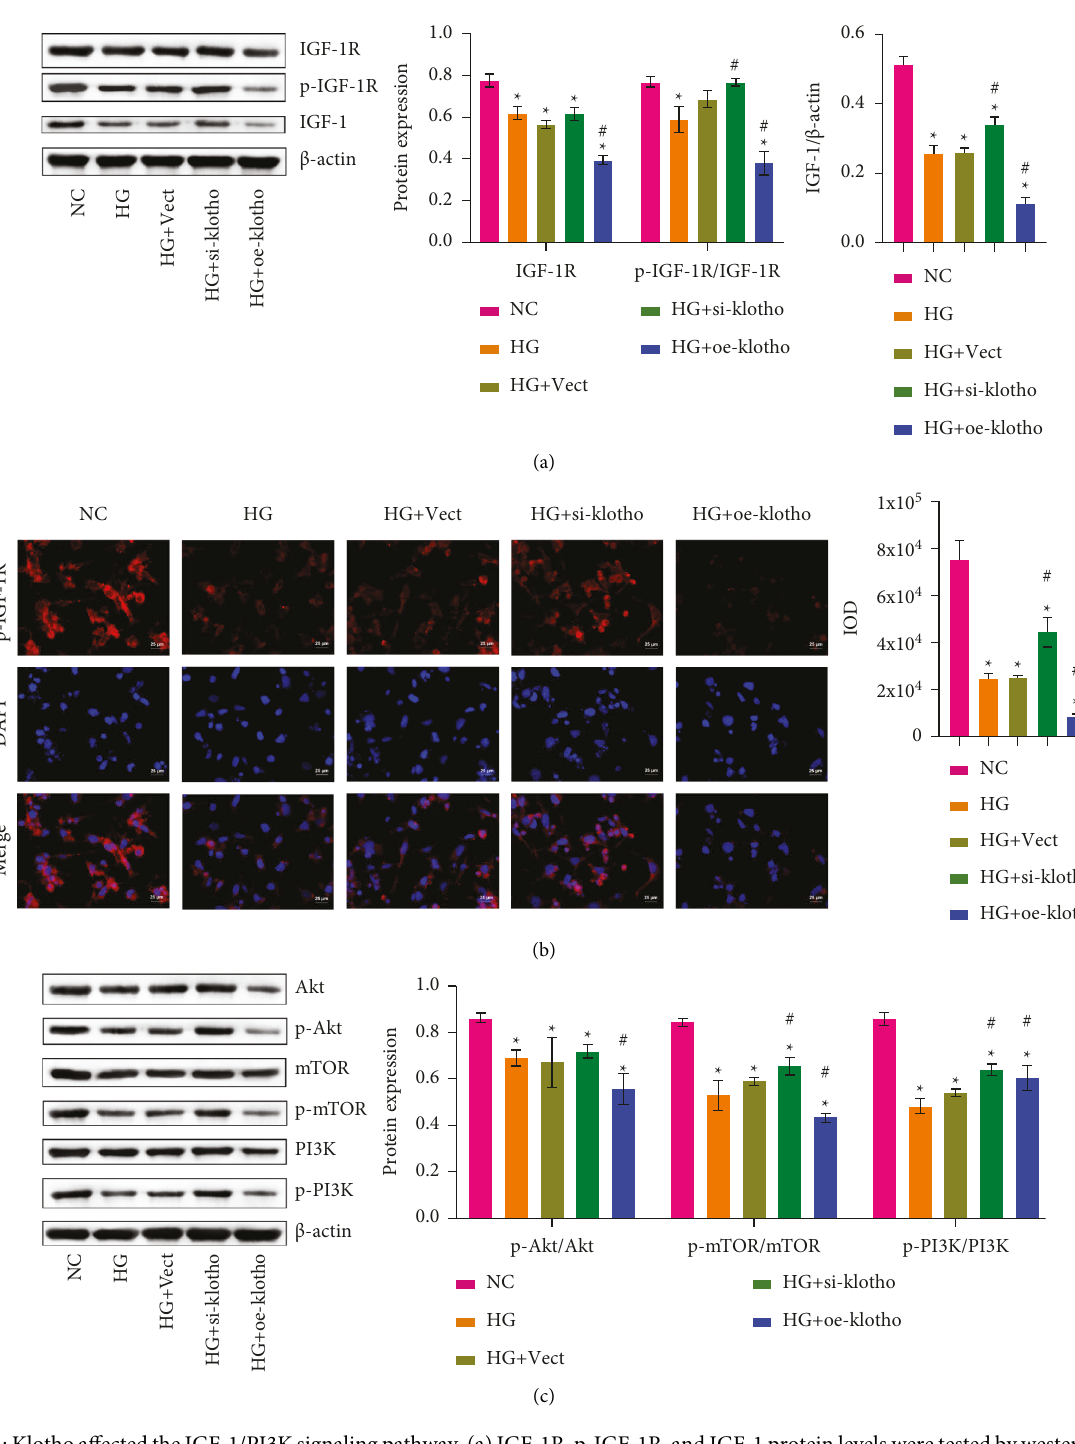
Figure 4: Klotho affected the IGF-1/PI3K signaling pathway. (a) IGF-1R, p-IGF-1R, and IGF-1 protein levels were tested by western blot. (b) Immunofluorescence was used to detect p-IGF-1R levels. (c) Western blot of PI3K/p-PI3K, Akt/p-Akt, and mTOR/p-mTOR protein levels. ∗ p < 0 . 05 compared with the NC group. # p < 0 . 05 compared with the HG